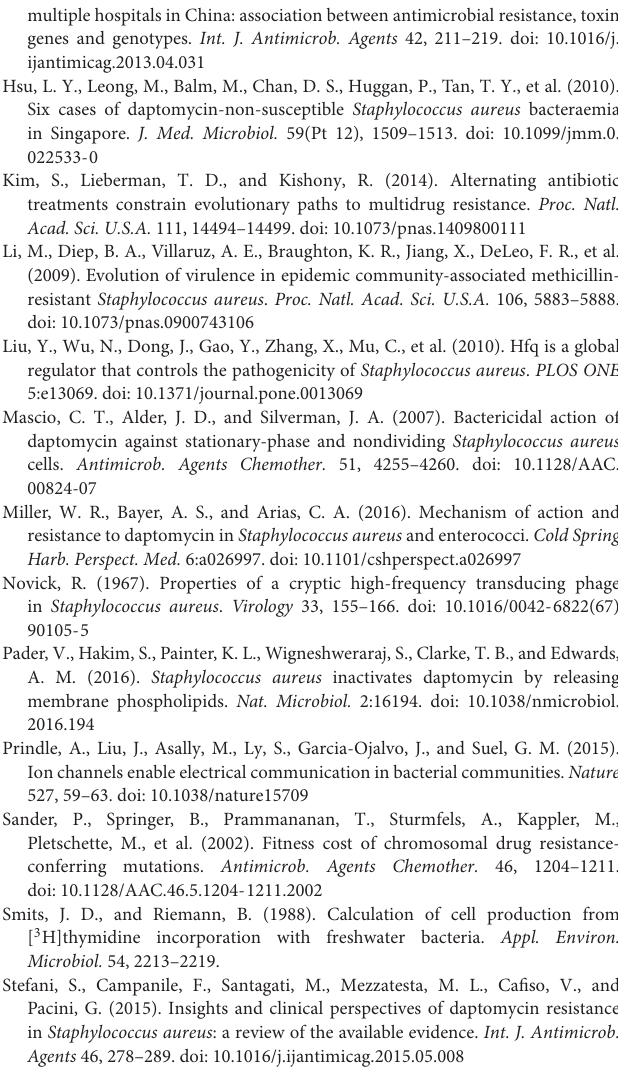
FIGURE S1 | In vitro serum tolerance of wild-type and mutant